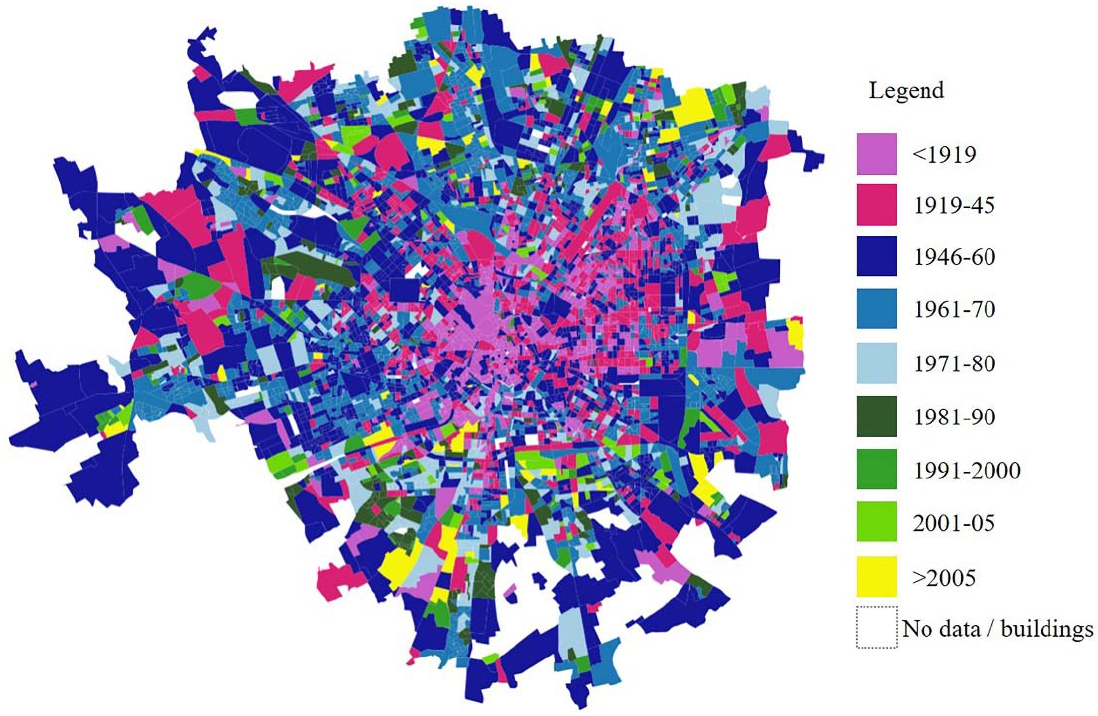
Figure 8. Map of Milan Census Units based on prevailing period of construction.